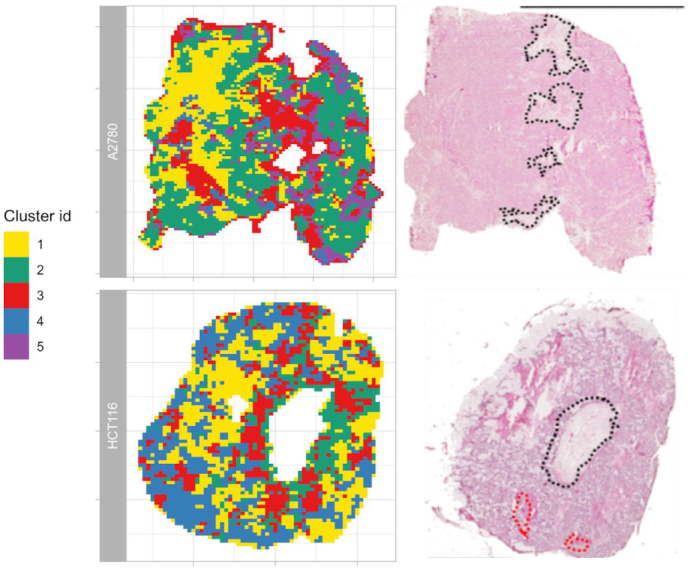
Comparison of tumor tissue optical image (right column) with its clustered image (left column) from MSI data of 2 tumor cell lines (A2780–1A9, HCT116). The black and red dots in the H&E-stained images represent the necrotic and fibrotic area, respectively. The optical images are adapted from Giordano et al. [10] published under CC BY license.